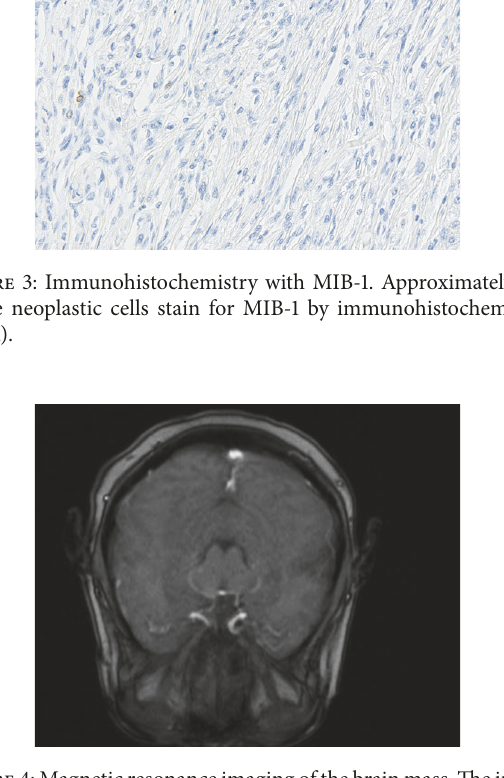
Figure 4: Magnetic resonance imaging of the brain mass. The image shows a small enhancing parasagittal